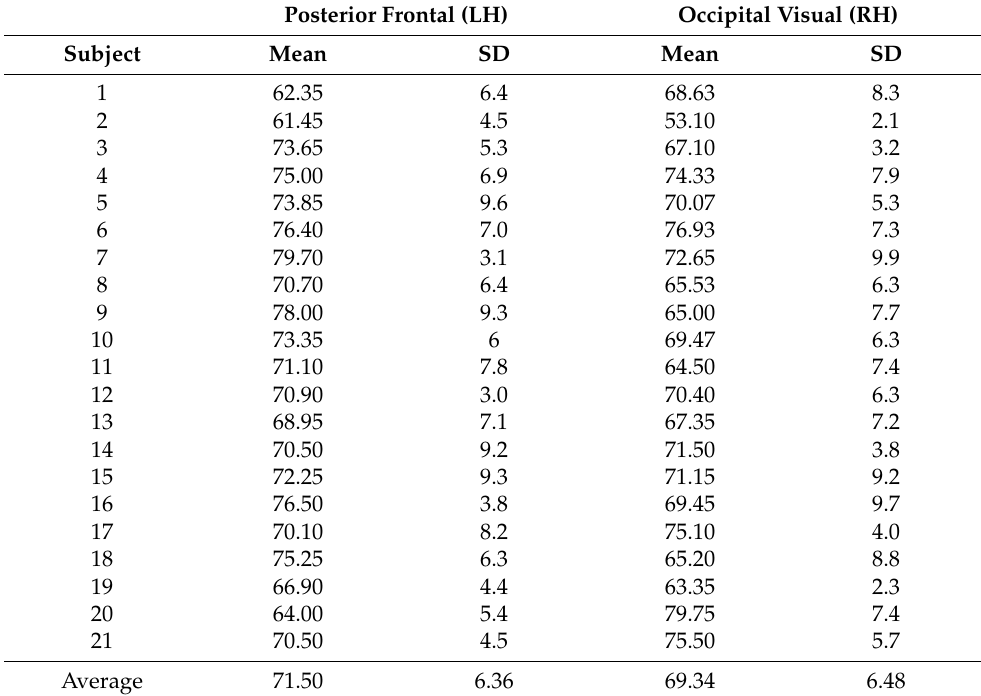
Table 2. Average (and SD) of T2* measurements at each two regions of interest for each study participant. Posterior Frontal (LH) Occipital Visual